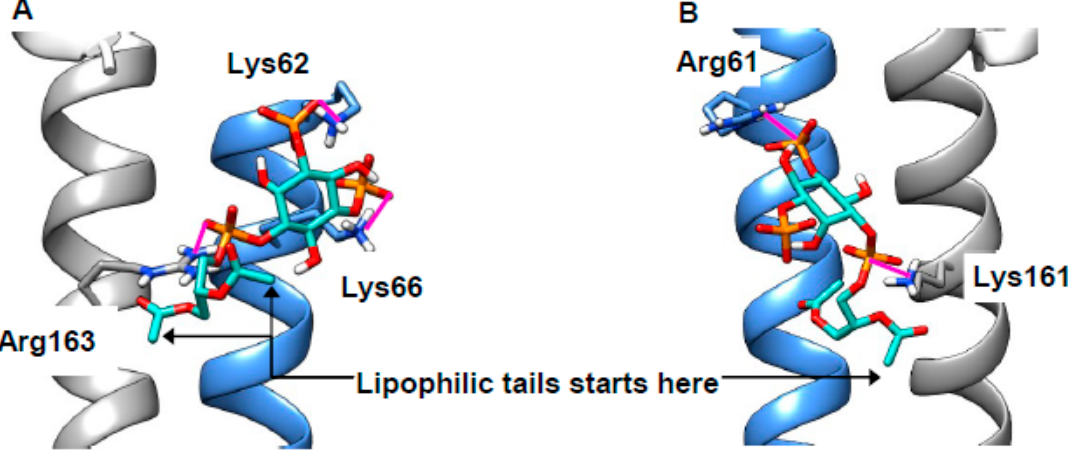
Figure 7. PI(4,5)P 2 can bind to two members of a SNARE bundle simultaneously. Sample poses of PI(3,5)P 2 (turquoise) bridging vesicle-associated membrane protein 8( VAMP8) (blue) and syntaxin 7 (grey) in the assembled Soluble NSF (N-ethylmaleimide Sensitive Fusion) protein attachment receptor (SNARE) bundle with zwitterionic interactions (magenta) ( A , B ).